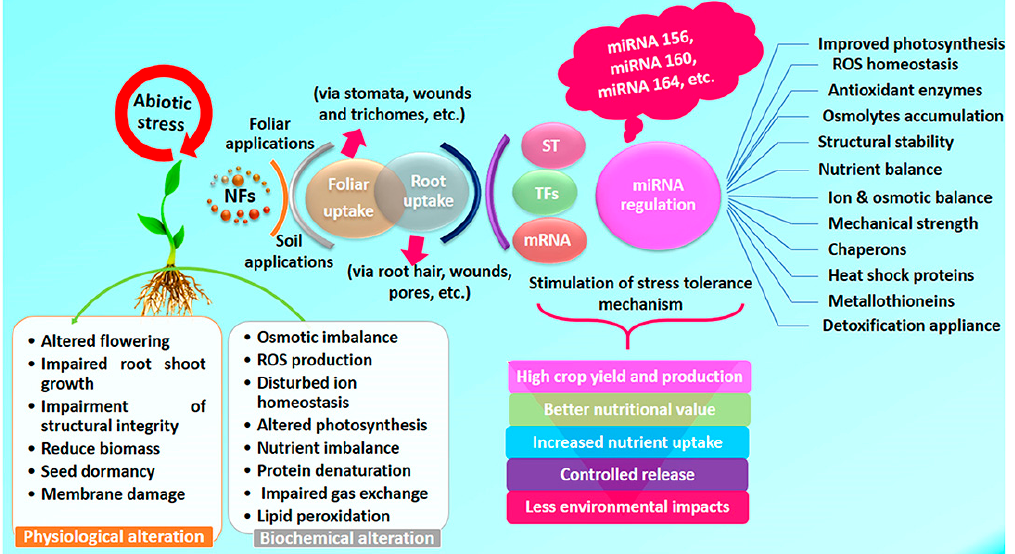
Figure 2. Nanofertilizer benefits in the face of abiotic stress. In [73] under Creative Commons Attribution License (CC BY).